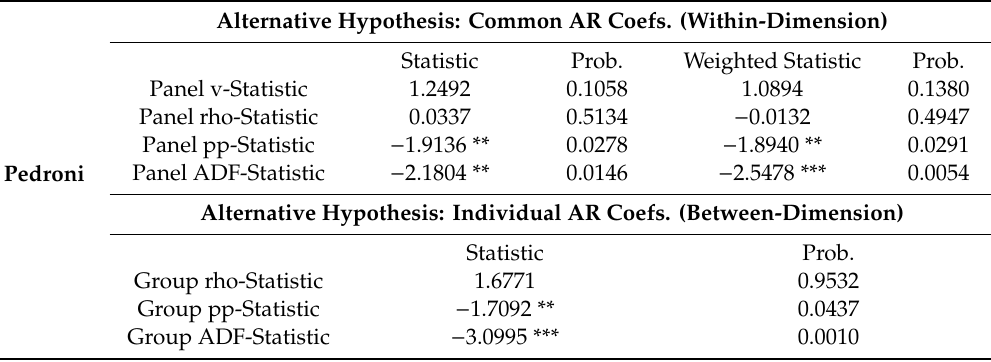
Table 3. Panel cointegration test results using the Pedroni